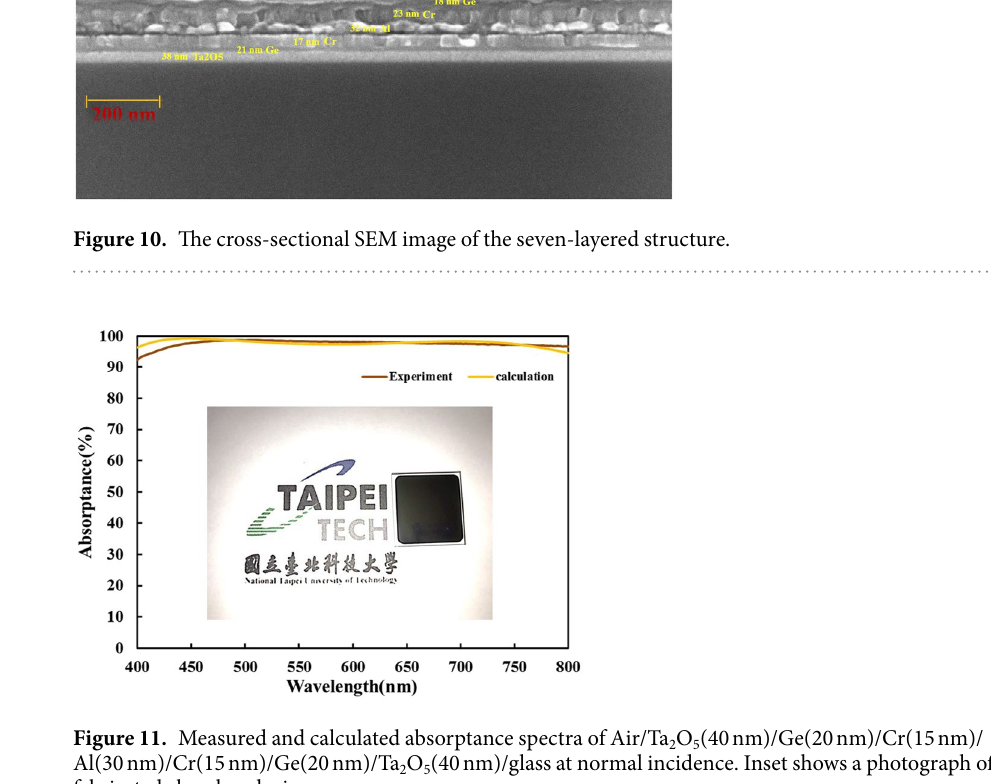
part of equivalent admittance varies within 1.25 ± 0.08 over the whole range of visible wavelengths. The imagi- nary part of the equivalent admittance is less than 0.25 over the range of visible wavelengths. At wavelengths from 430 nm to 500 nm, Im ( E ) is less than 0.1. The index of refraction linearly from 0.11 at a wavelength of 400 nm to 1.42 at a wavelength of 700 nm. The extinction coefficient increases from 1.8 at a wavelength of 400 nm to 2.0 at a wavelength of 530 nm, and remains around 2.1 at wavelengths from 500 nm to 700 nm. The high extinction coef- ficient around 2.1 at a wavelength of 700 nm yields a skin depth of 53 nm. The skin depth is also obtained by near-field simulation. The skin depths at wavelengths of 400 nm and 550 nm are 35 nm and 43 nm, respectively. Figure 9(c) plots the distribution of the field amplitude in the multilayer that is illuminated by electromagnetic waves with an electric field amplitude of unity. The designed seven-layered metamaterial was deposited on a transparent BK7 glass substrate by sputtering evaporation. Figure 10 shows the cross section of scanning electron microscopy image. The thickness of the seven-layered stack is 194 nm. Figure 11 shows the measured and calculated absorptance spectra at normal inci- dence. The figure indicates that high absorption is achieved without a mirror underneath the metamaterial. The measured absorptance exceeds 92% over the entire range of visible wavelengths and the absorptance exceeds 98% at wavelengths from 456 nm to 643 nm. The discrepancy between measured and calculated absorptance spectra arises from the error in the thickness of the Ta 2 O 5 layer. According to the analysis of the thickness tolerance for seven-layer absorber, a 10% error in the thicknesses of the deposited Ta 2 O 5 , Ge and Cr layers would cause discrep- ancies in the average absorptance between measured and simulated spectra at normal incidence, of approximately 1.54%, 0.35% and 0.11%, respectively. Figure 12 plots the measured absorptance for wavelengths from 400 nm to 700 nm and angles of incidence from 20° to 70°. The sever-layered stack exhibits excellent angular tolerance and polarization-independent performance. The absorption of p-polarized waves exceeds 92% for wavelengths from 400 nm to 800 nm even at an angle of incidence of 65°. The absorption of s-polarized waves exceeds 95% for wavelengths from 427 nm to 572 nm and angles of incidence from 20° to 40°. The s-polarized absorption is slightly weaker than the p-polarized absorption at short wavelengths around 400 nm and long wavelengths around 800 nm. In conclusion, a broadband antireflection equivalent layer, comprising a symmetric film stack, is developed in the admittance diagram. The condition for admittance matching in the diagram is elucidated to facilitate the